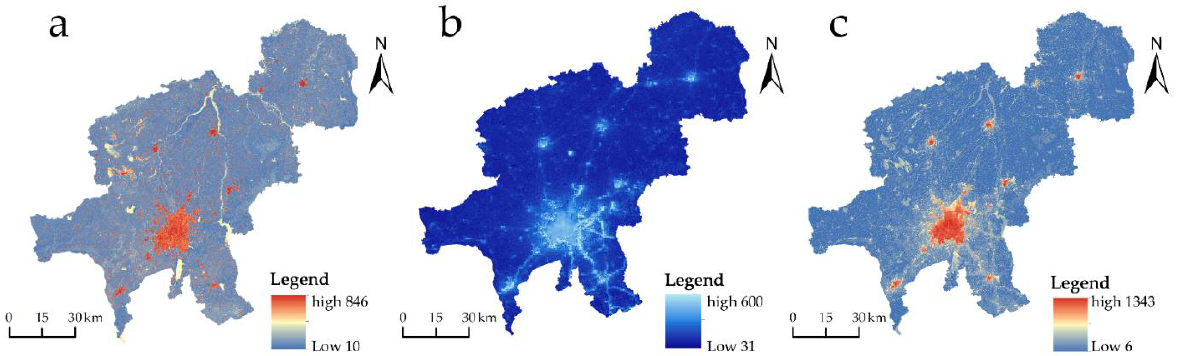
Figure 4. Ecological resistance surface. ( a ) Spatial distribution of the basic resistance surface. ( b ) The spatial distribution of nighttime light intensity (TLI). ( c ) The spatial distribution of the modified resistance surface.